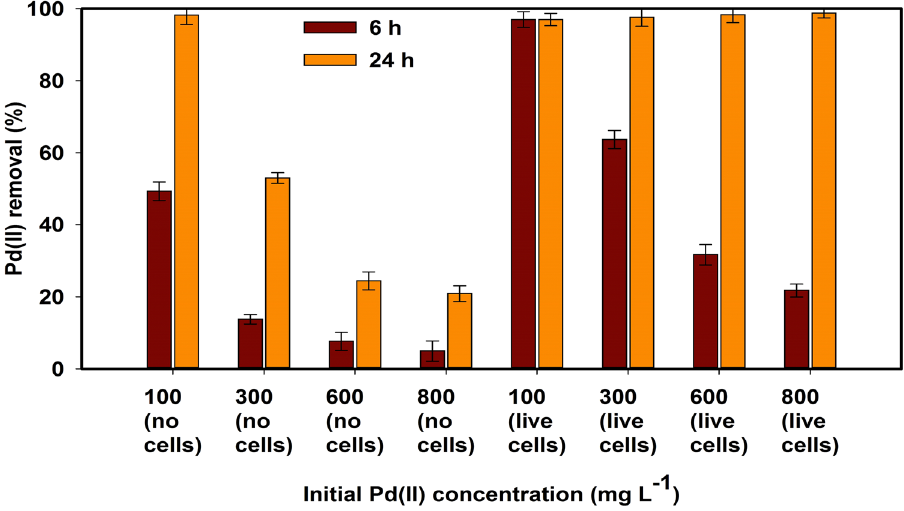
Figure 3. Initial Pd(II) concentration effect on the Pd(II) removal measured at 6 h and 24 h during Pd nanoparticles synthesis using no microbial cells and live microbial